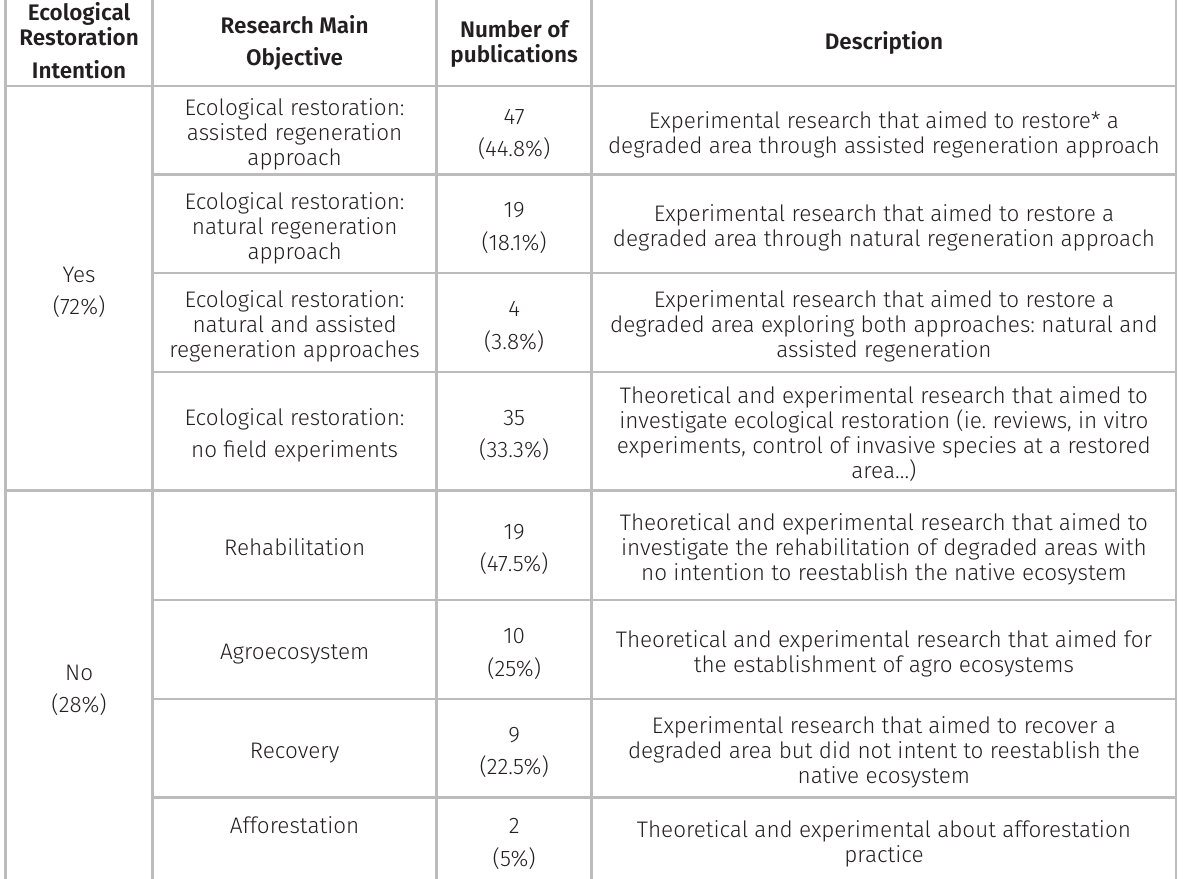
Table III. The objectives of the selected publications Ecological Restoration